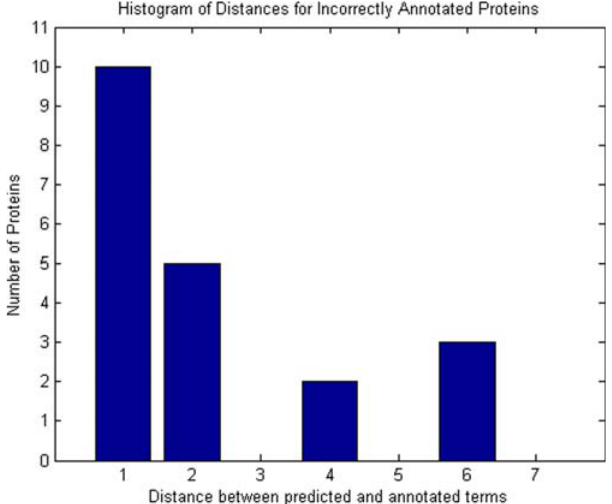
Figure 2. Histogram of distances between the wrongly predicted GO terms and the ‘true’ GO